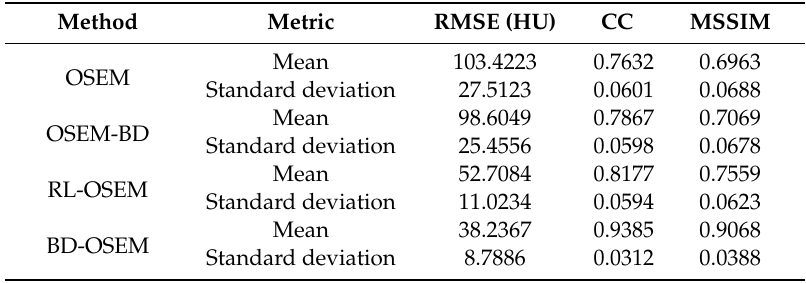
Table 3. Evaluation of motion artifact reduction performance on head